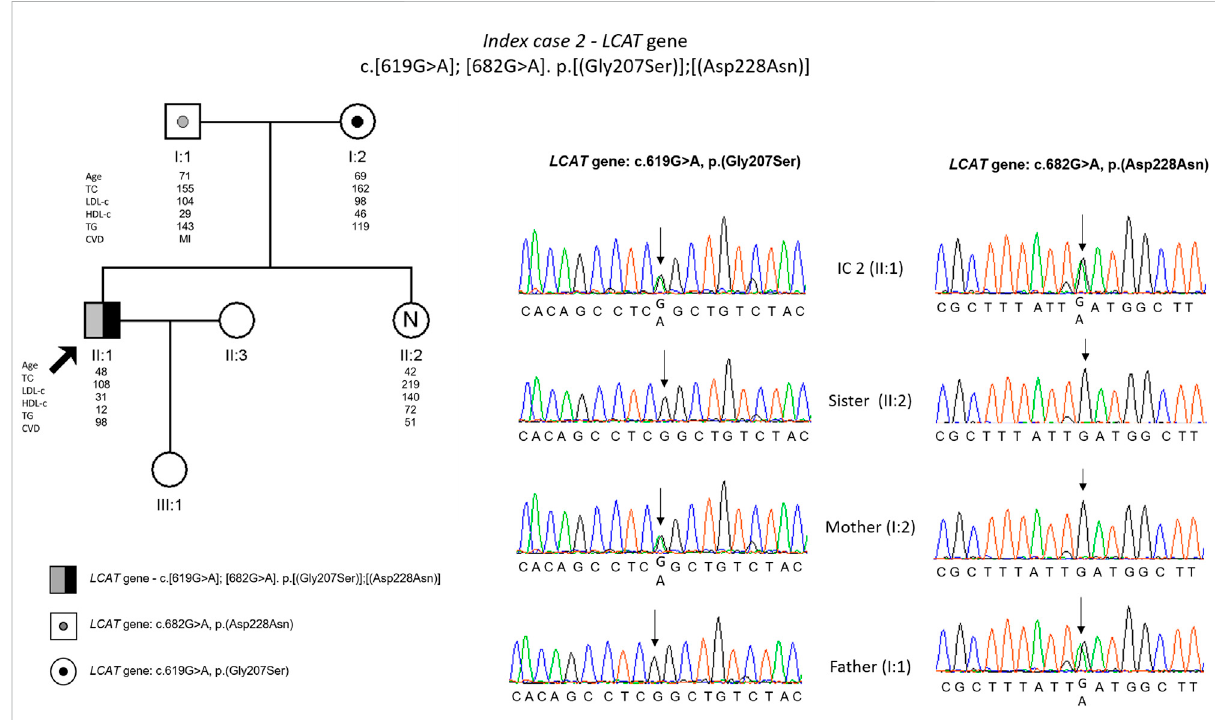
FIGURE 2 Arrow indicates index case 2 (IC2). Age (in years) and lipid pro fi le in mg/dL are under each symbol. Black point symbol represent heterozygous individual for the variant in LCAT gene, c.619G > A, p.(Gly207ser); grey point symbol represent heterozygous individual for the variant in LCAT gene, c.682G > A, p.(Asp228Asn); the compound heterozygote is represented with half- fi lled in black and half- fi lled in grey; Partial sequence LCAT gene of IC2 and family